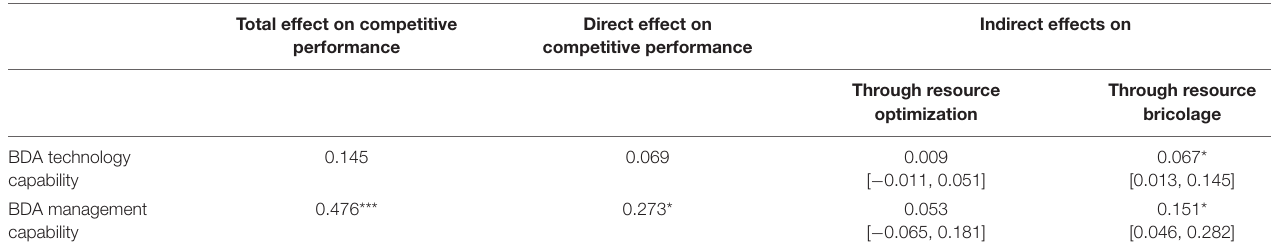
TABLE 5 | Mediation analysis results ( N =